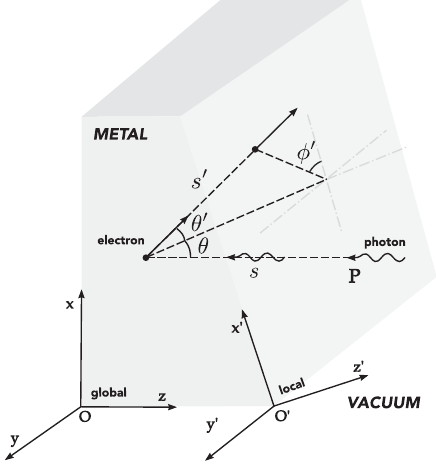
FIG. 3. The schematic plot for the bulk photoemission on a part of a rough metallic cathode. The definitions of coordinates and variables are marked in the plot. The main difference between the photoemission on a rough cathode and on a smooth cathode is that on the rough cathode, the photons are mostly not normal incident. As shown in the plot, a photon is injected into the surface with an incident angle θ . After traveling along some distance s , the photon is absorbed by an electron, and then that electron travels towards the rough surface and emits from the cathode. It is obvious that the center of the emitted area is not point P anymore, it will have a small offset from point P